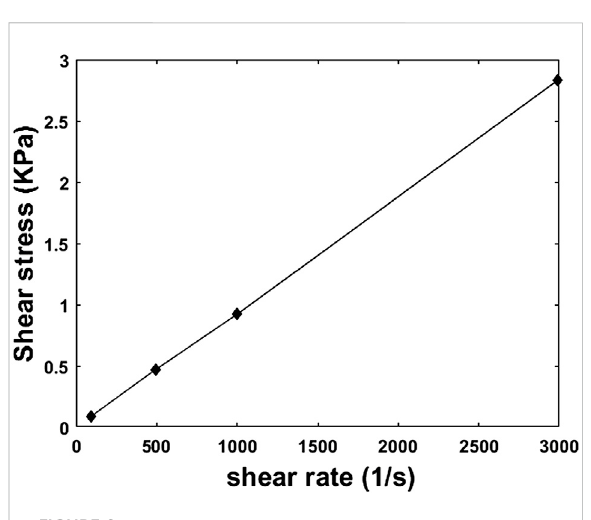
FIGURE 9 Relationship between shear stress and shear rate of silicone oil measured by the custom capillary rheometer.